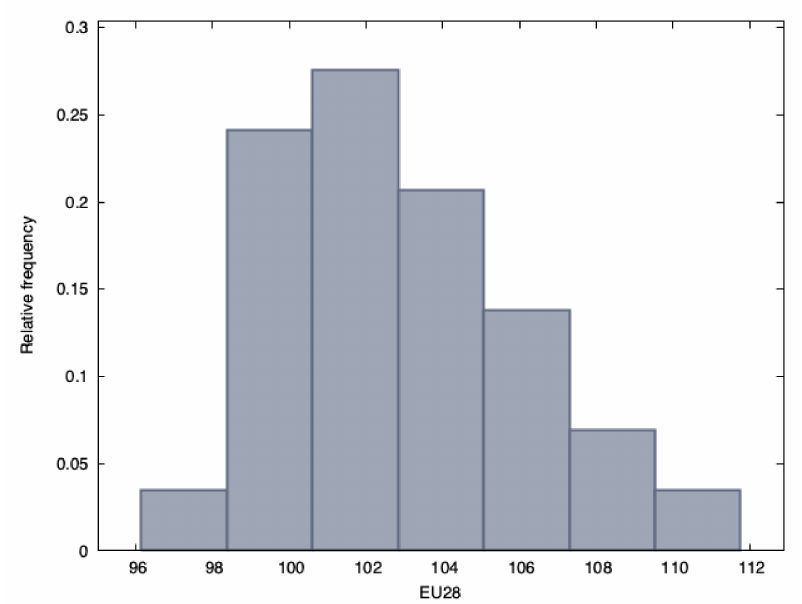
Figure 3. Relative frequency of average growth rate of the REC in the EU, 2015–2019 (developed by the authors based on